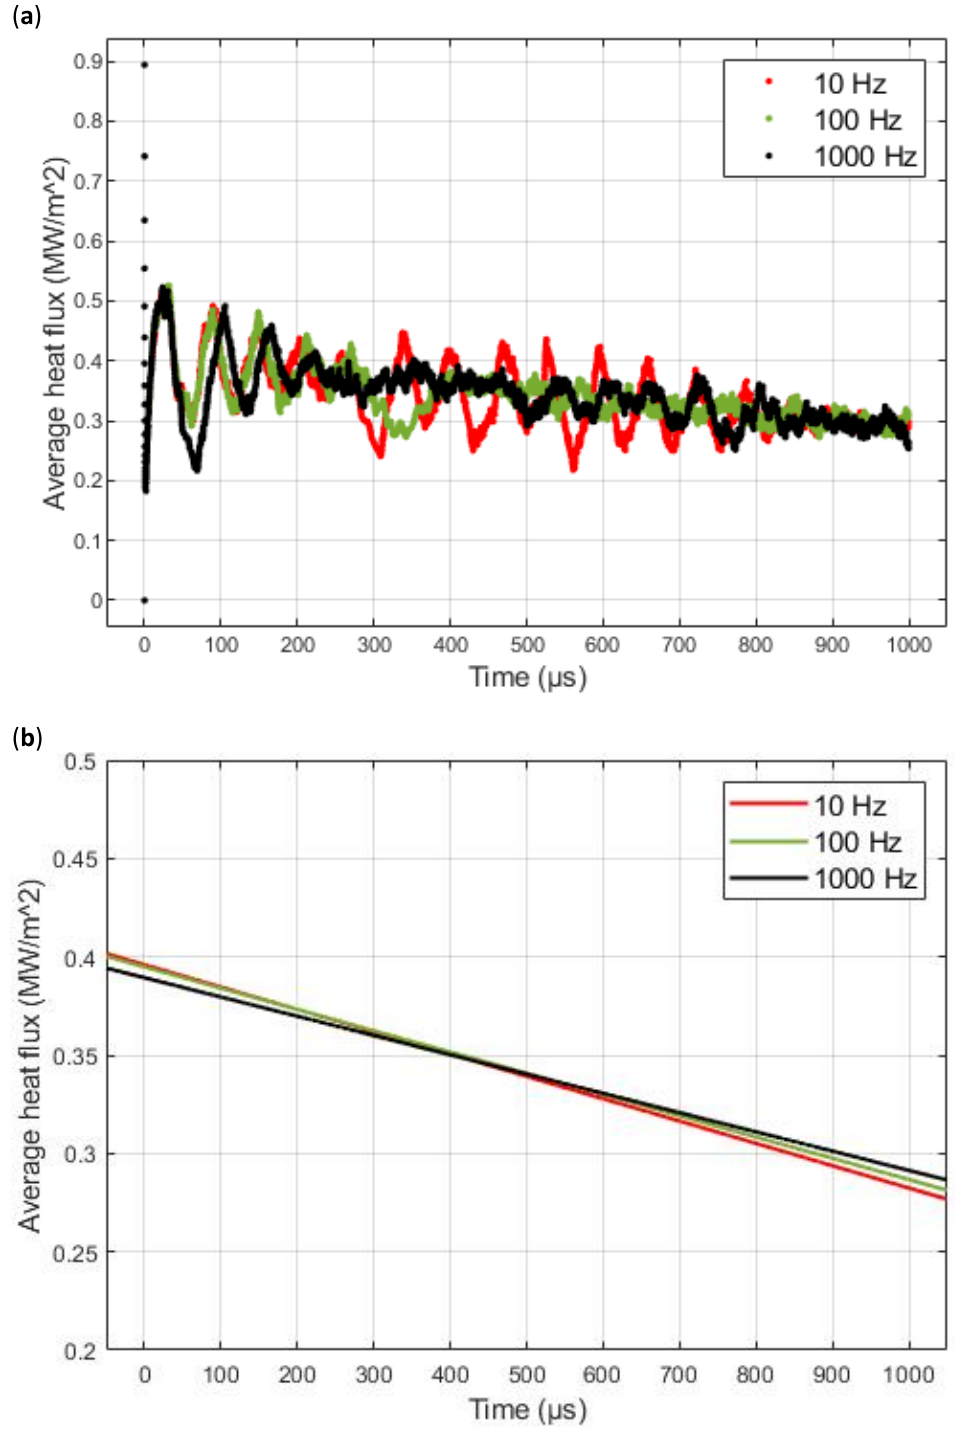
Figure 11. Surface-averaged heat flux for a surface vibration amplitude of 0.1 mm at frequencies of 10 Hz, 100 Hz, and 1000 Hz: ( a ) simulated values; ( b ) linear approximations to simulated values.